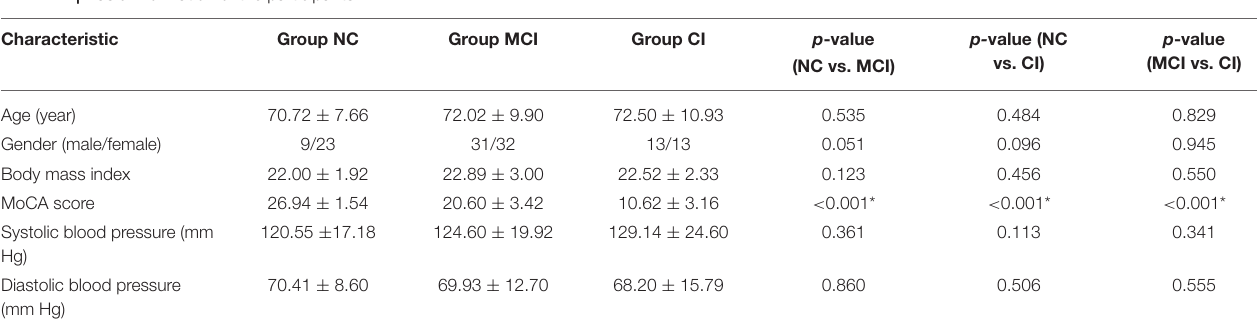
TABLE 1 | Basic information of the